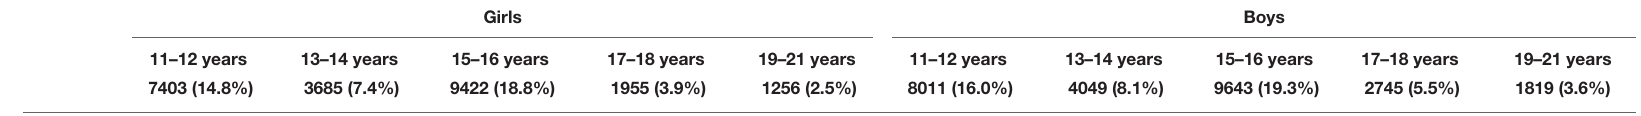
TABLE 1 | Socio-demographic characteristics, sport licenses and performances according to age and